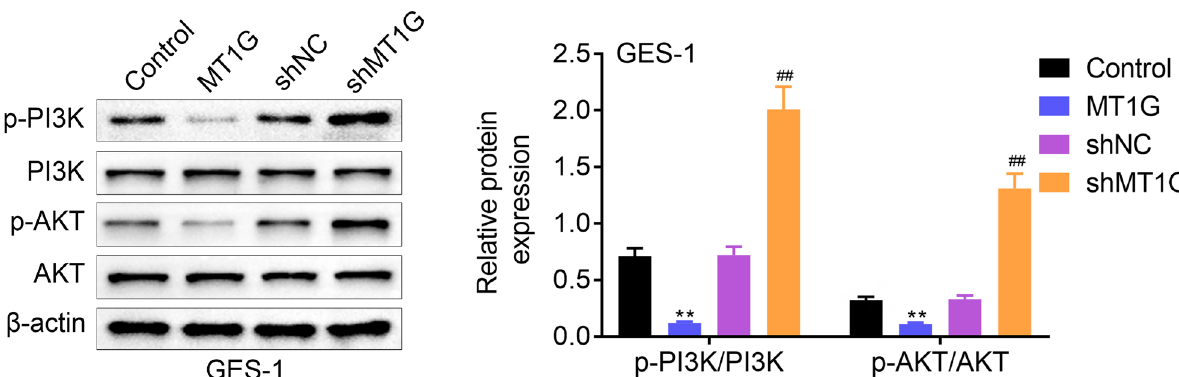
Figure 6 – MT1G deficiency induces PI3K/AKT signaling in gastric normal cell. Gastric normal cells (GES-1) were divided into four groups based on its different treatment with plasmids transfection, including MT1G overexpression plasmids and related control plasmids, MT1G knockdown plasmids- sh MT1G and matched negative control plasmids-shNC. The expression of AKT, p-AKT, PI3K, p-PI3K in MT1G overexpression or knockdown GES-1 cells was measured by western blotting. Error bars represent data from three independent experiments (mean±SD). ＊＊ P<0.01.